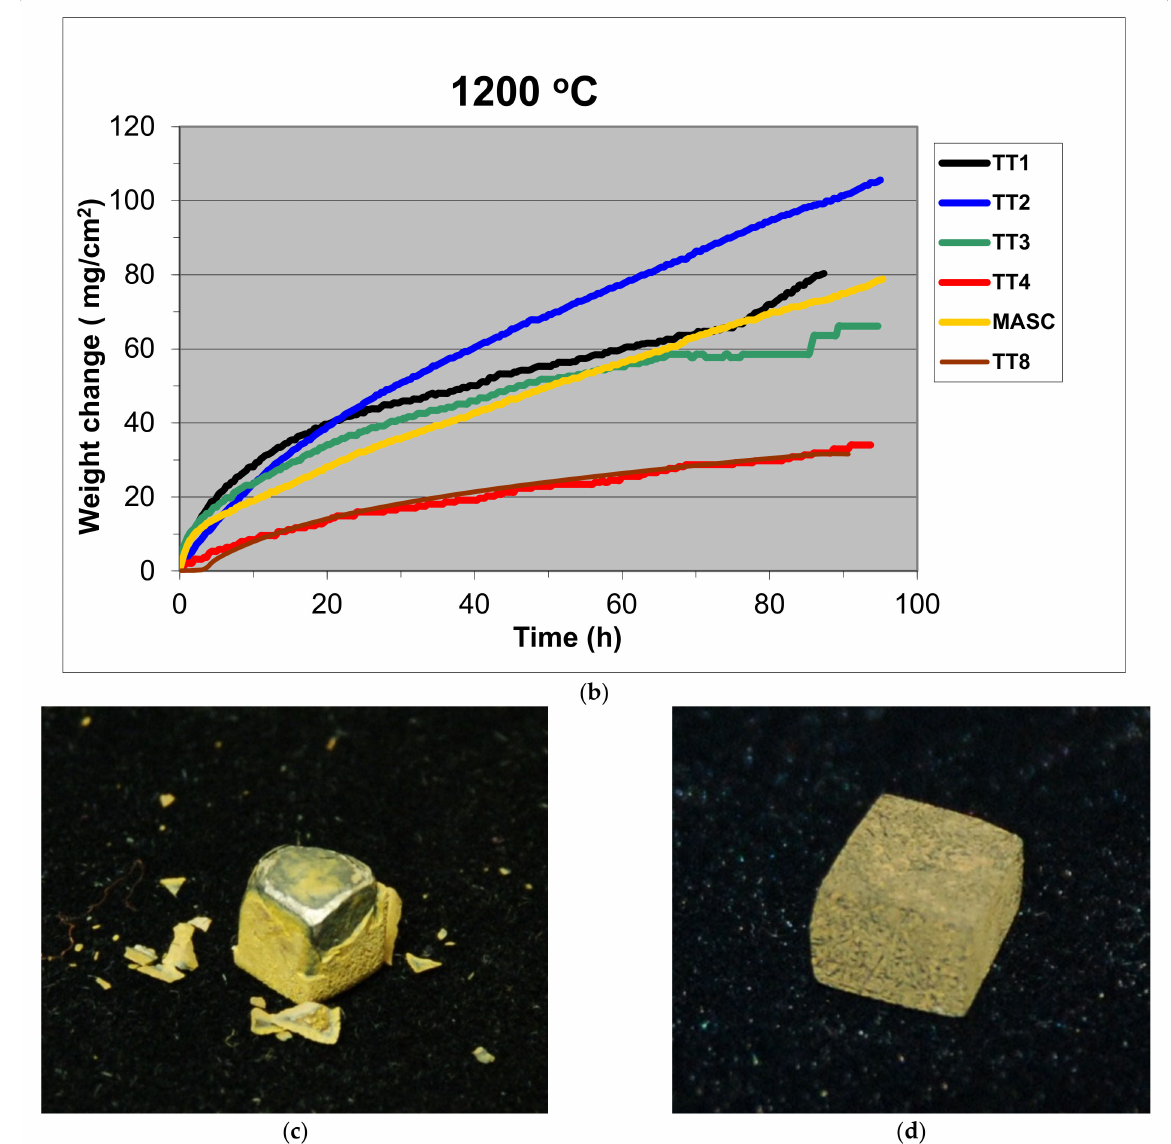
Figure 2. Mass change ( ∆ W/A) versus time of alloys TT1, TT2, TT3, TTT4, TT8 and MASC at ( a ) 800 ◦ C and ( b ) 1200 ◦ C. Colours: black TT1, blue TT2, green TT3, red TT4, yellow MASC, brown TT8. Specimens of TT4 and TT8 after oxidation ( c ) at 1200 ◦ C and ( d ) 800 ◦ C,